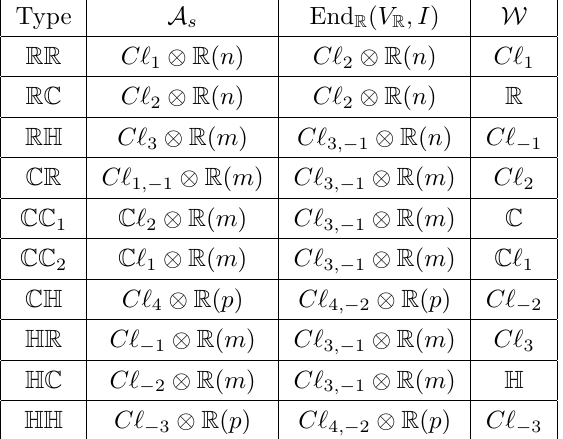
Table 3 . The Dyson Types matched with the superalgebras A s